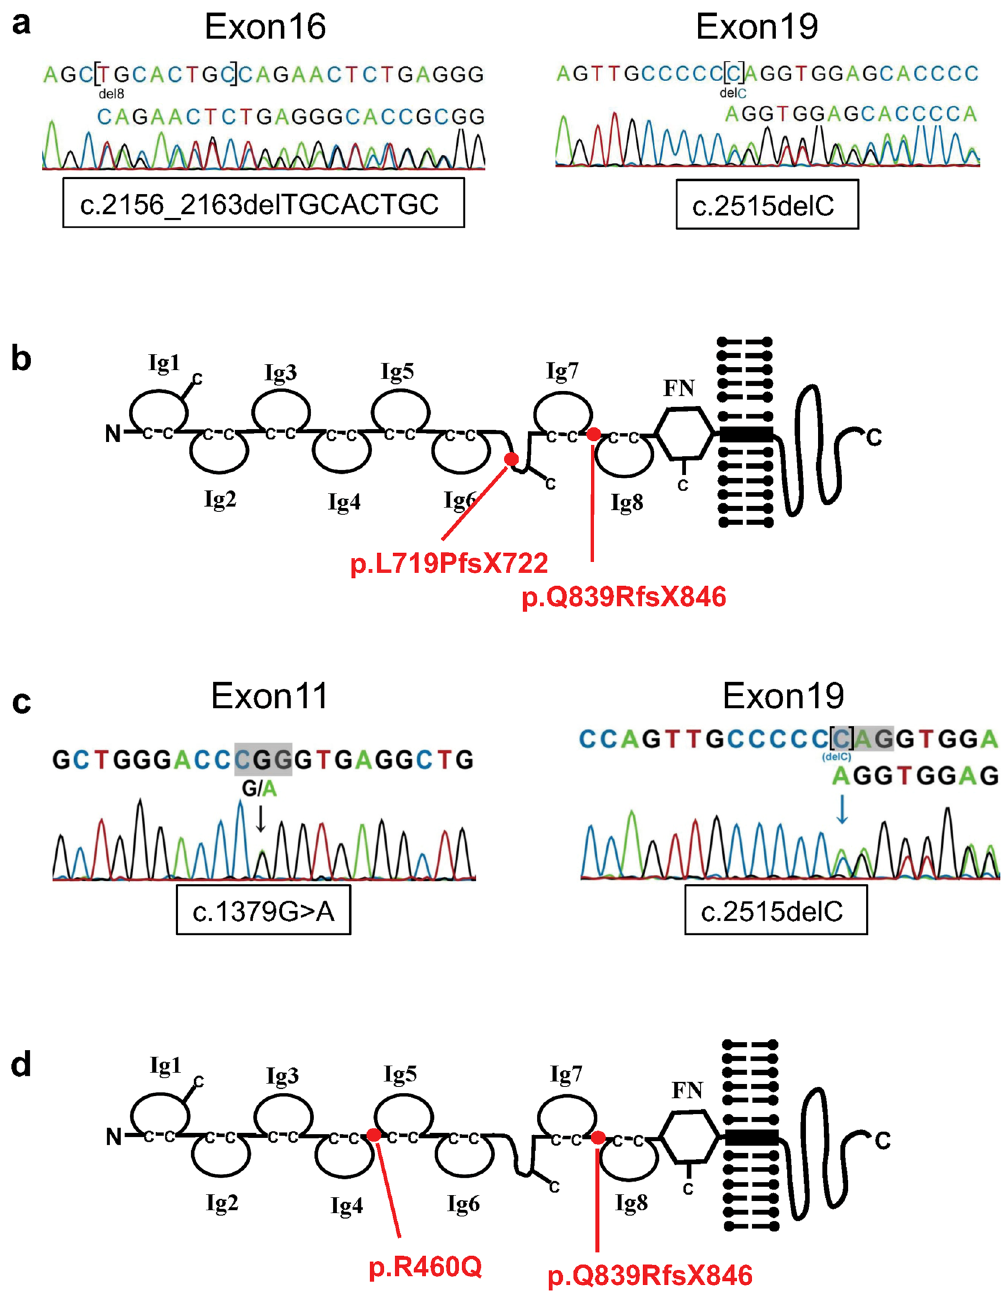
Figure 1. Identification of NPHS1 mutations in two nephrotic patients. ( a , b ) Mutations in the NPHS1 gene and NEPHRIN protein in Patient 1 (biallelic frameshift mutations). ( c , d ) Mutations in the NPHS1 gene and NEPHRIN protein in Patient 3 (missense mutation and frameshift mutation). Ig: immunoglobulin-like domain; FN: fibronectin-like domain. The mutations on the two alleles are shown in one